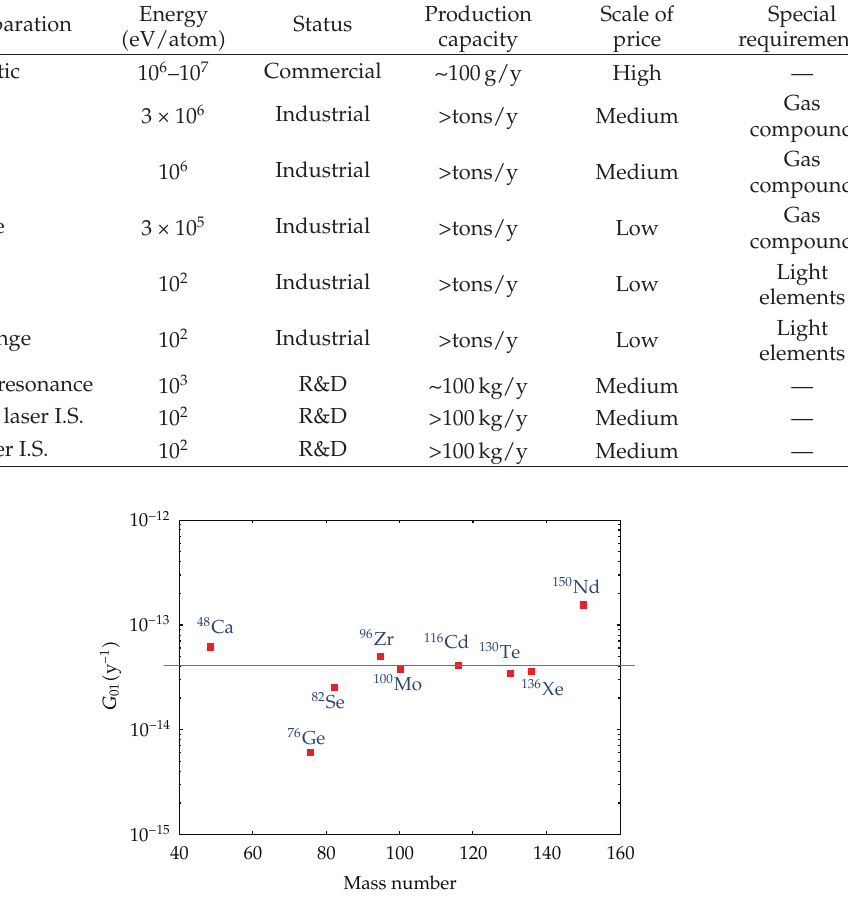
Table 5: Existing methods for isotope separation. The technologies relevant for neutrinoless double-beta decay are indicated in the fourth and in the three last lines.